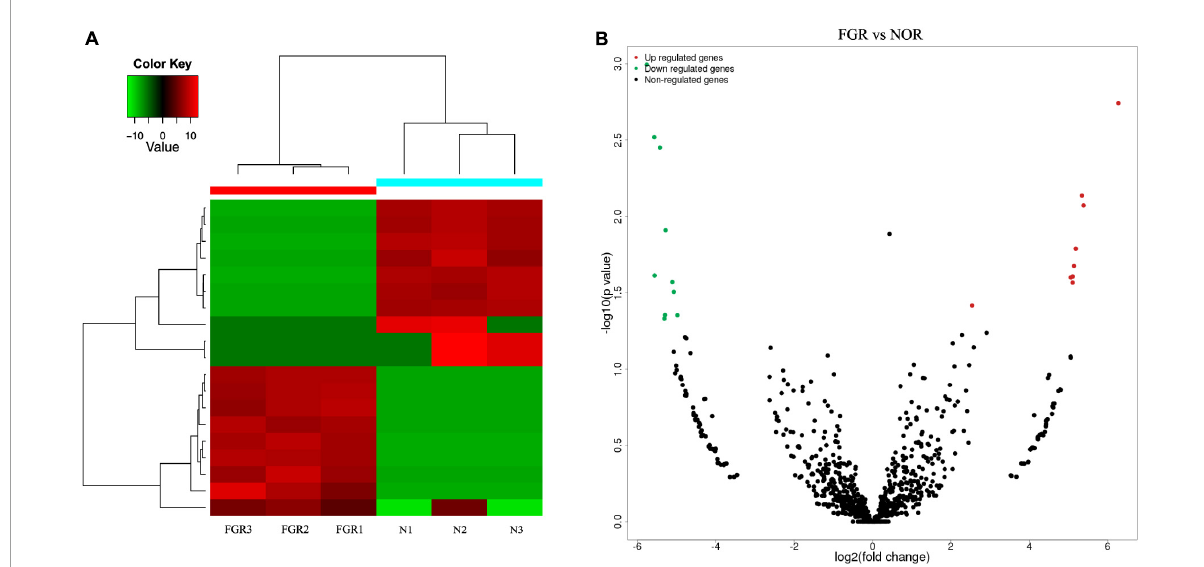
FIGURE1 Bioinformatic analysis of the results of circRNA. (A) Heatmap of differentially expressed circRNAs between groups. (B) Volcano plots of differentially expressed circRNAs between groups. Red: up-regulated; green: down-regulated.